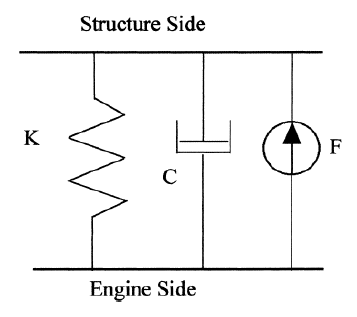
Fig. 7. Mechanical model of the active rubber mount [33].